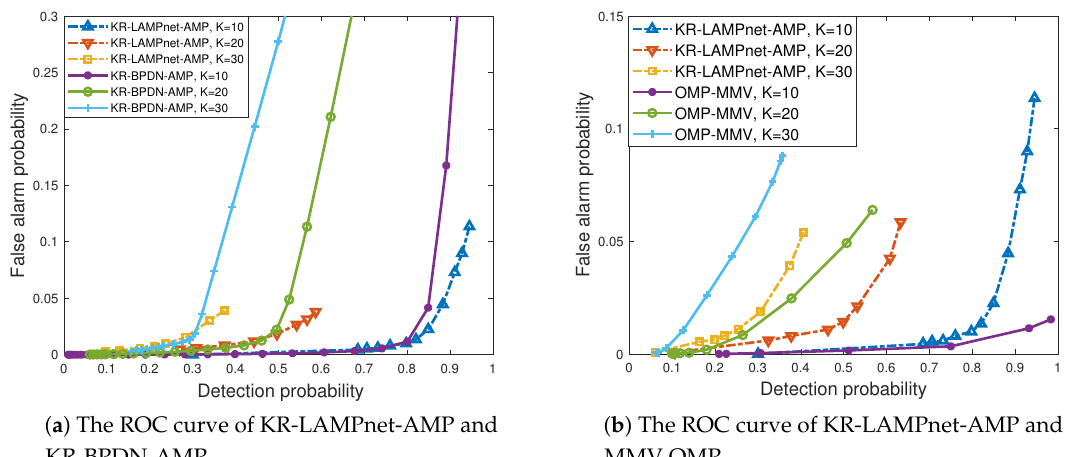
Figure 4. Comparision of KR-basis pursuit de-noising approximate message passing (BPDN-AMP), orthogonal matching pursuit (OMP)-multiple measurement vector (MMV) and KR-learning AMP network (LAMPnet)-AMP.